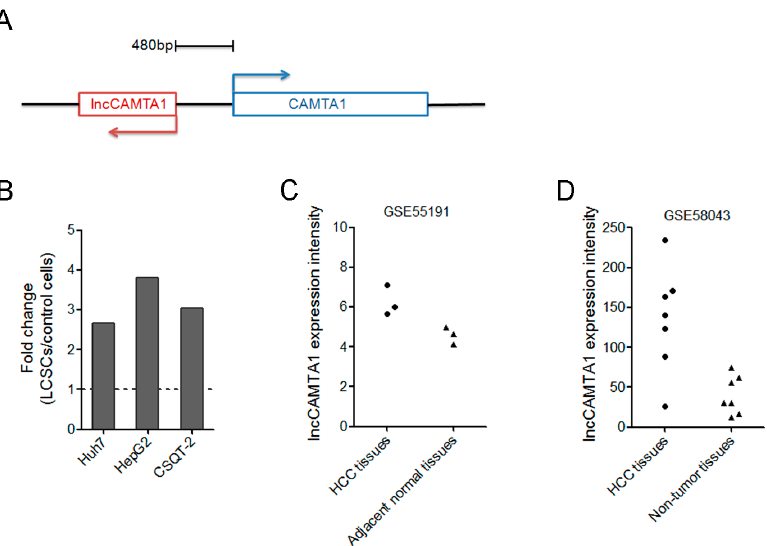
Figure 1. lncCAMTA1 expression pattern in public database of liver cancer stem cells (LCSCs) and hepatocellular carcinoma (HCC). ( A ) Schematic illustration of the genomic organization of lncCAMTA1 and calmodulin binding transcription activator 1 (CAMTA1). Arrows indicate transcription direction; ( B ) lncCAMTA1 is upregulated in LCSCs in comparison with their respective control cells; ( C ) lncCAMTA1 is upregulated in HCC tissues from GSE55191 data; ( D ) lncCAMTA1 is upregulated in HCC tissues from GSE58043 data.